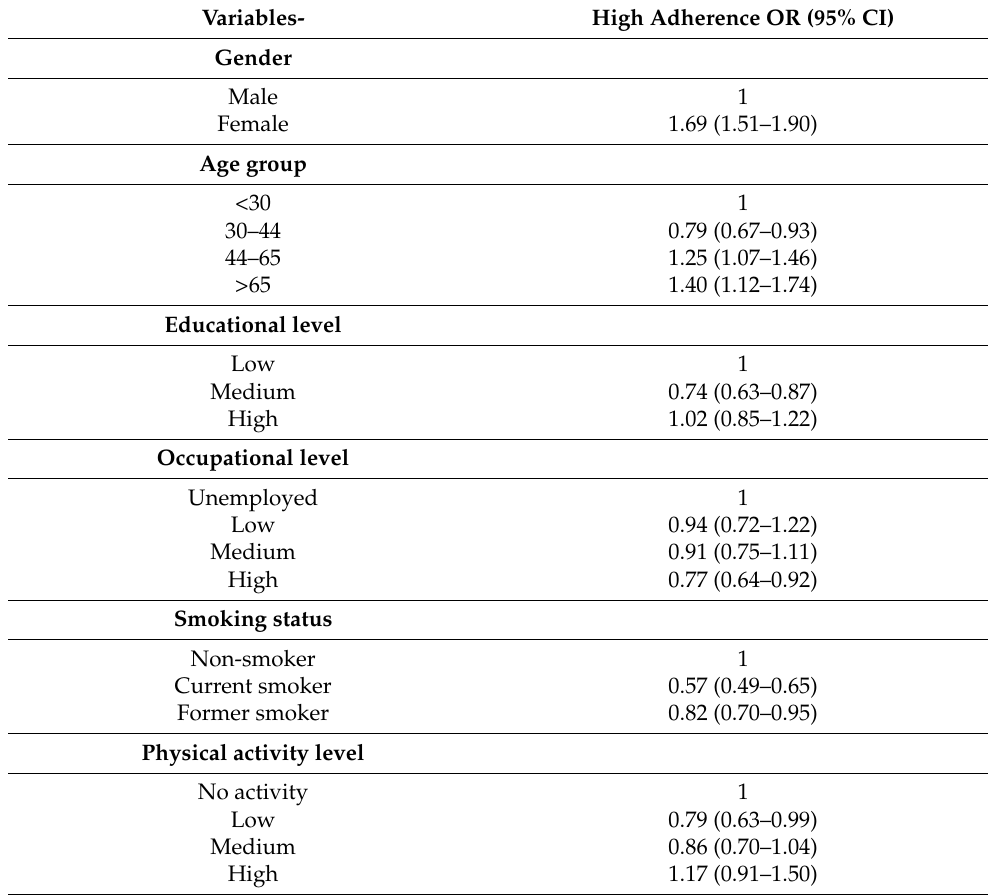
Table 2. Association between demographic characteristics and high adherence to Mediterranean diet (high vs. medium/low).